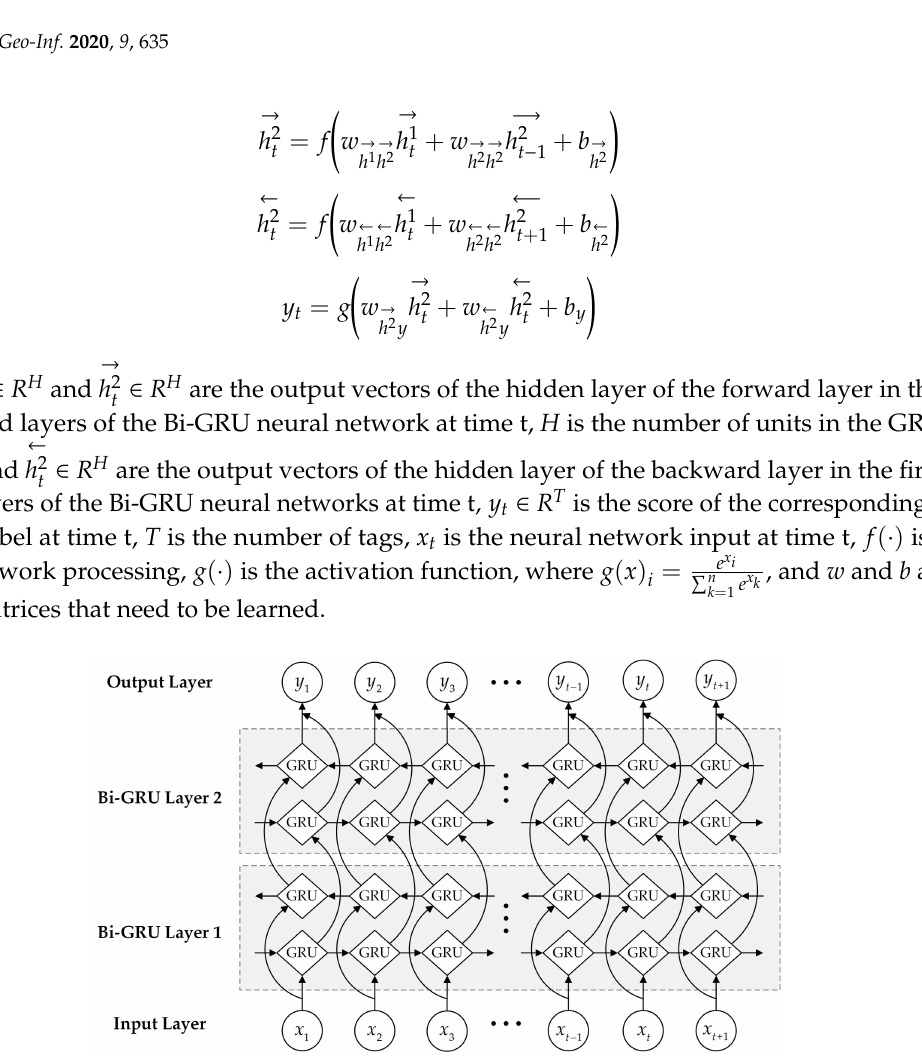
Figure 3. The Bi-GRU neural network unit